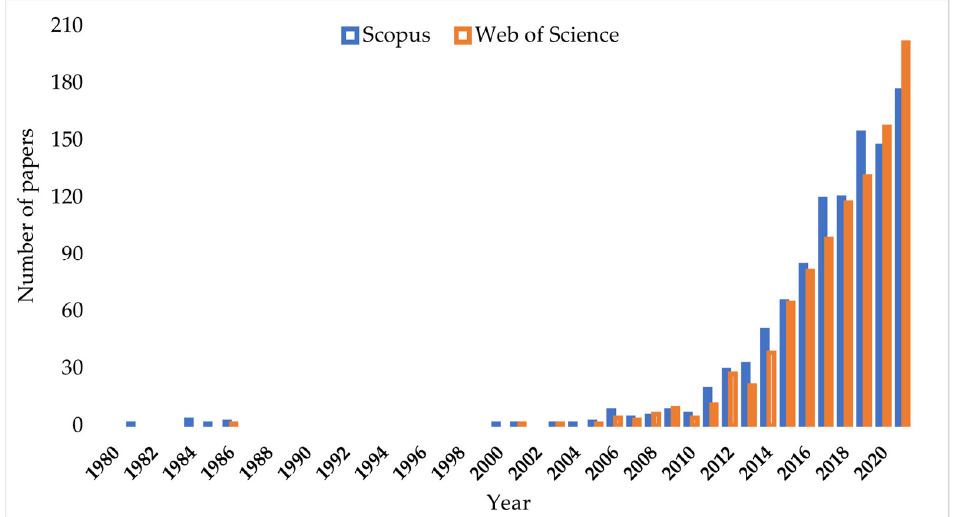
Figure 1. The number of search results using the keyword “PVT photovoltaic thermal” from Scopus and Web of Science databases.